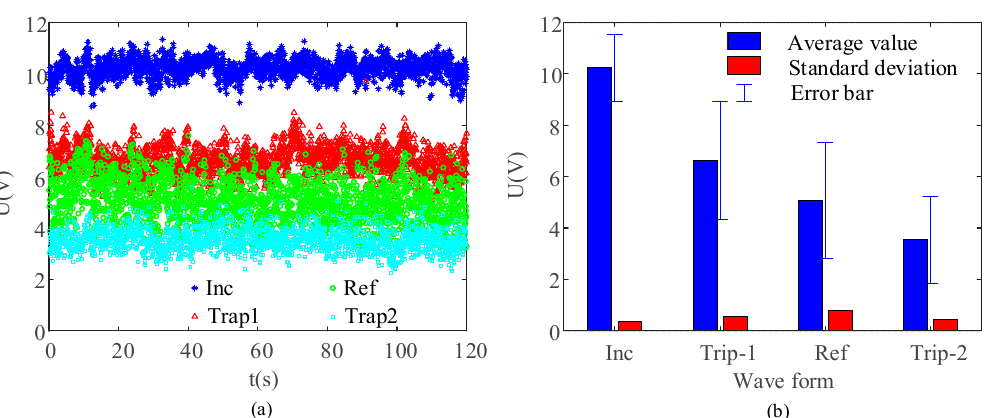
Figure 6. ( a ) Recorded peak-voltage signals of the capacitor in the impact process of 120 s and ( b ) fluctuation data of peak voltage .